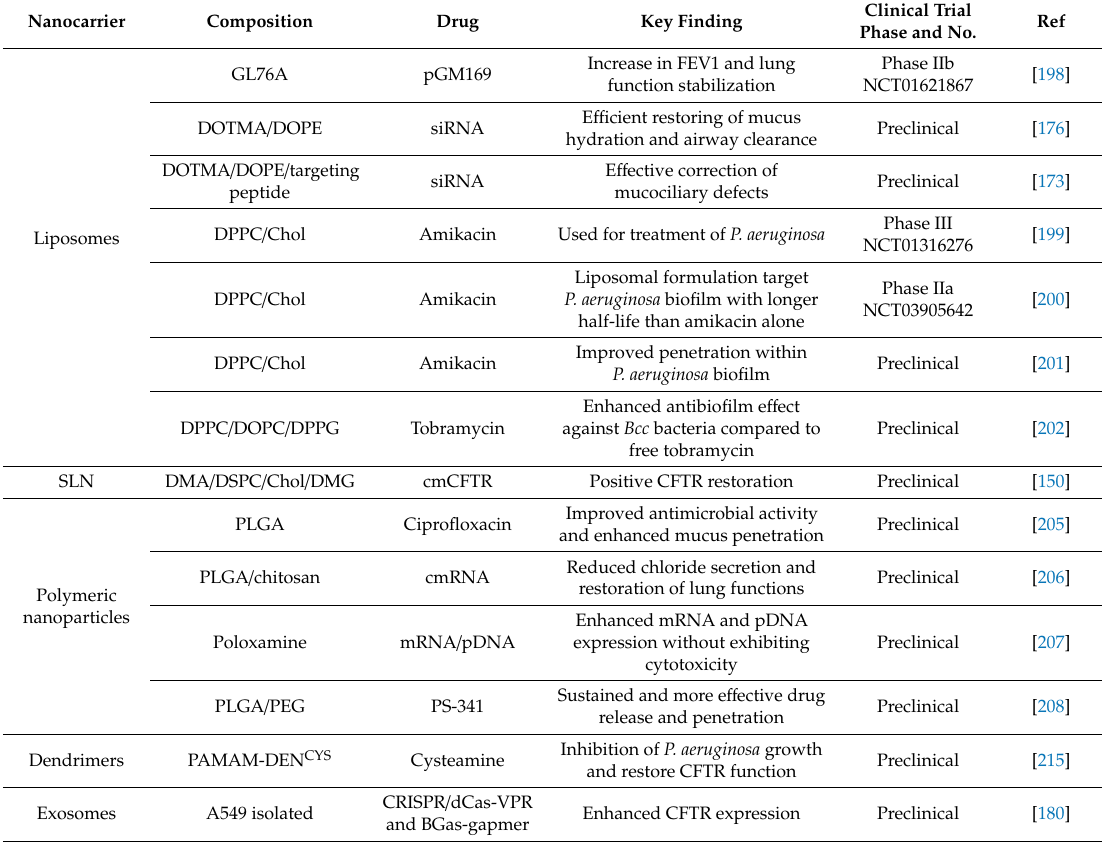
Table 2. Non-viral vectors commonly used for gene and drug delivery in CF patients.